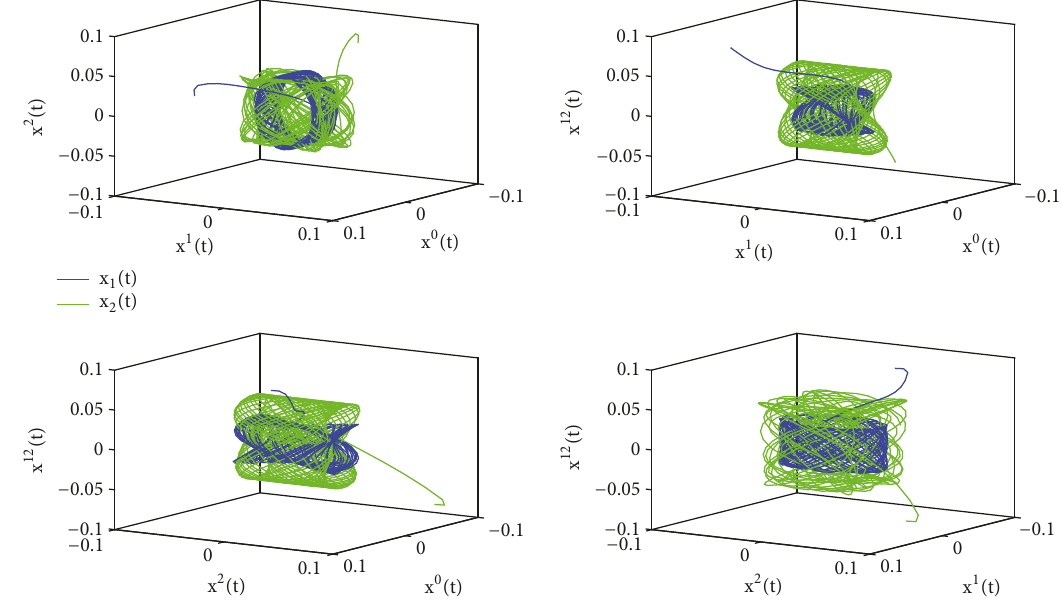
Figure 3: Curves of 𝑥 0 (𝑡) , 𝑥 1 (𝑡) , 𝑥 2 (𝑡) , and 𝑥 12 (𝑡) in 3-dimensional space for stable